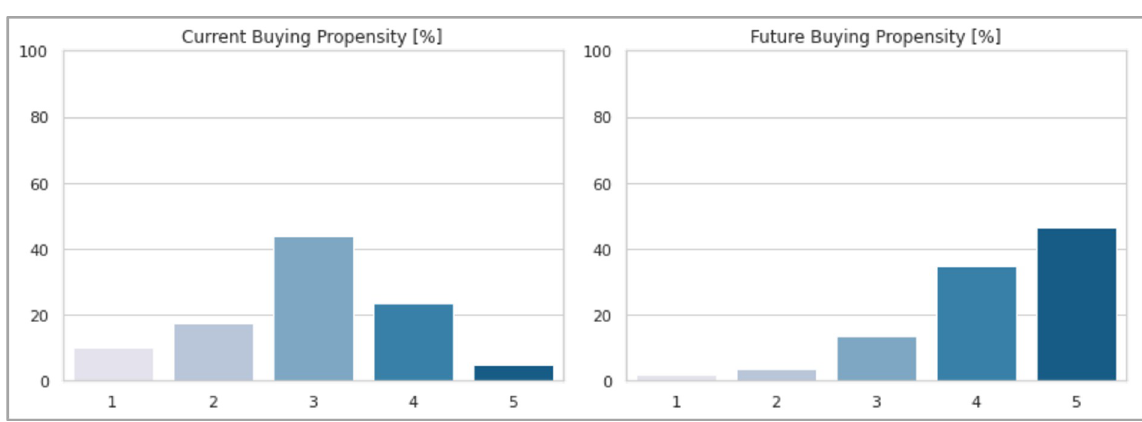
Fig 13. Current and future buying propensity of respondents.